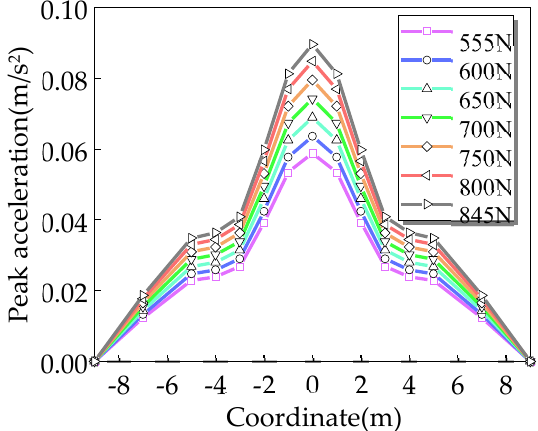
Figure 13. Effect of self-weight on peak acceleration response.